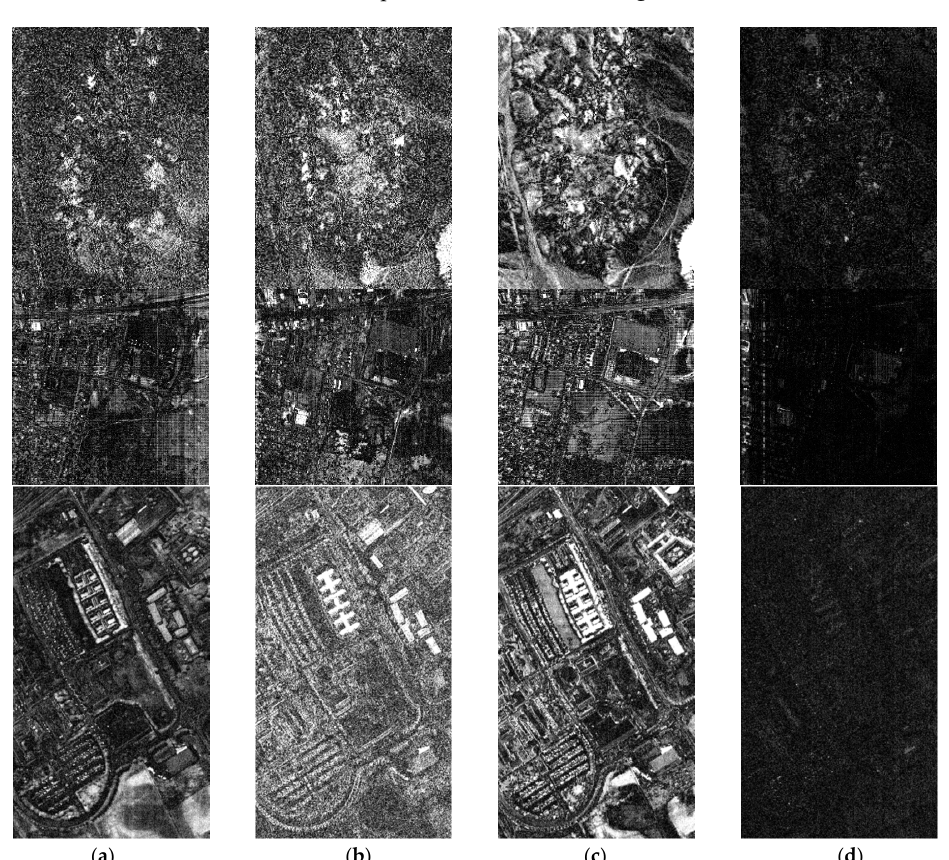
Figure 6. Original and reconstructed pseudocolor images achieved by different algorithms on different datasets near the 0.05 sampling rate, from top to bottom Cupriete, Urban, and PaviaU: ( a ) original, ( b ) MT-BCS, ( c ) CPPCA, ( d ) SSHCS, ( e ) SpeCA, ( f ) SSCR_SU, and ( g ) DCHS.